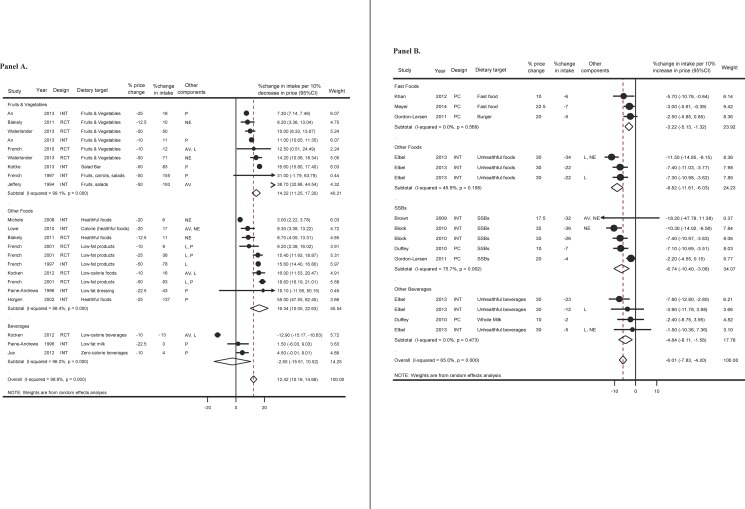
Prospective relationship of price decrease (Panel A) and increase (Panel B) with dietary consumption. Studies included randomized controlled trials (RCTs), nonrandomized interventions (INT), and prospective cohorts (PC). Some studies included other intervention components such as advertising/promotion of price change (P), nutrition education (NE), labeling (L), or change in food/beverage availability (AV). Effect sizes were pooled using inverse-variance-weighted random-effect meta-analysis. Statistically significant heterogeneity was seen for all I2 values>90% (Q-test p<0.001) and I2 = 75% (Q-test p = 0.002), but not I2 = 45% (Q-test p = 0.158) or I2 = 0% (Q-test p> = 0.470).